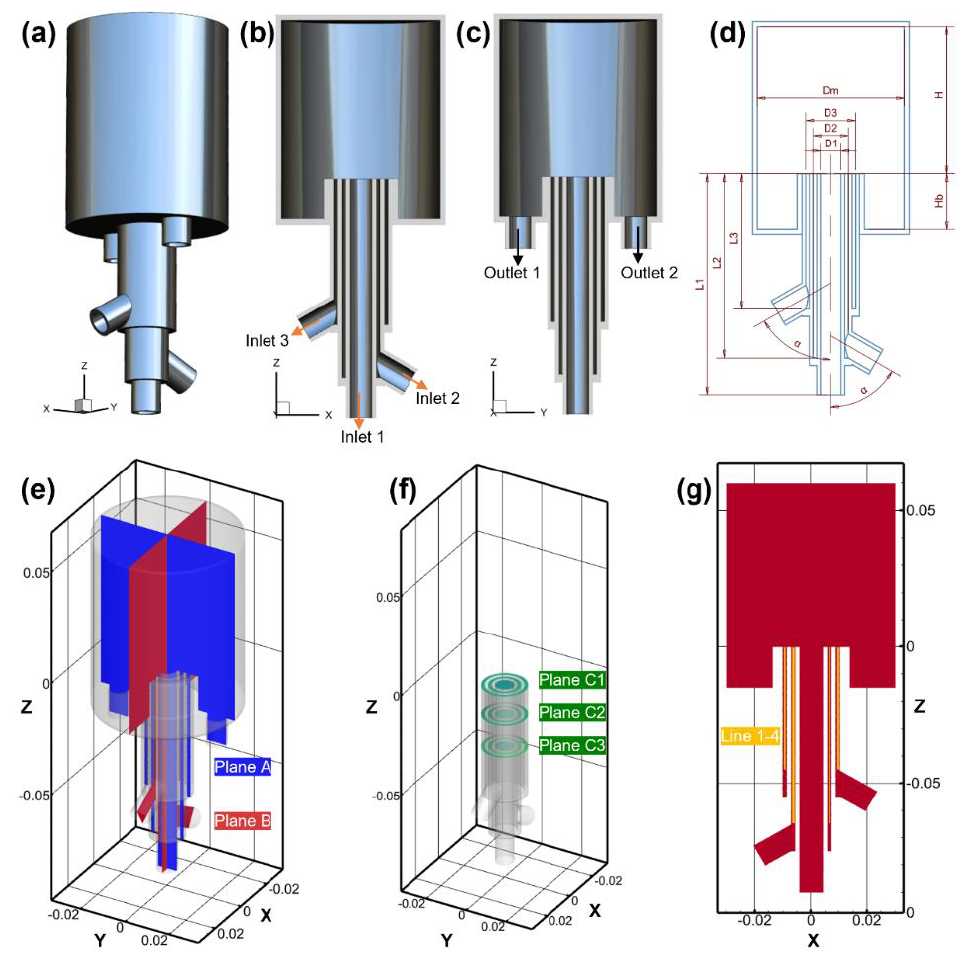
Figure 2. ( a – c ) Geometric modeling of powder mixer; ( d ) Dimensioning diagram; ( e – g ) The data Figure 2. (a–c) Geometric modeling of powder mixer; (d) Dimensioning diagram; (e–g) The data sampling sampling position.